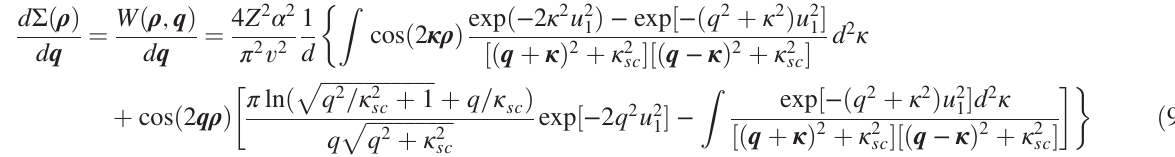
þ 1 sc ffiffiffiffiffiffiffiffiffiffiffiffiffiffiffiffi q 2 þ κ 2 sc